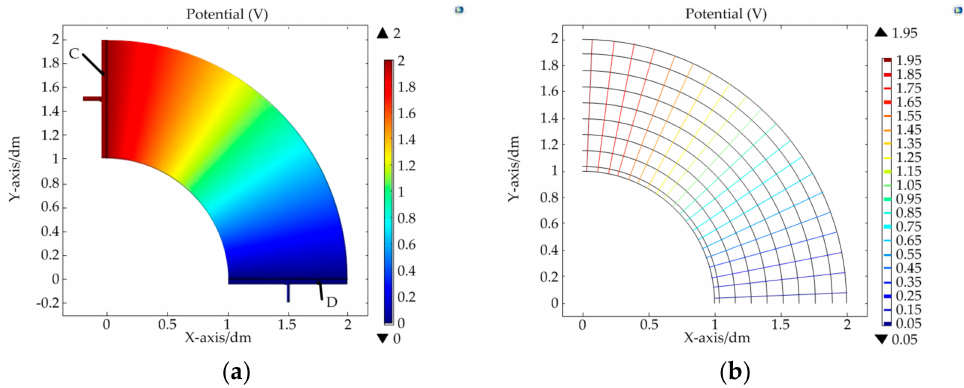
Figure 10. Simulation results of the lower conductive layer: ( a ) distribution map of the electric potential; ( b ) diagram of the electric field line and equipotential